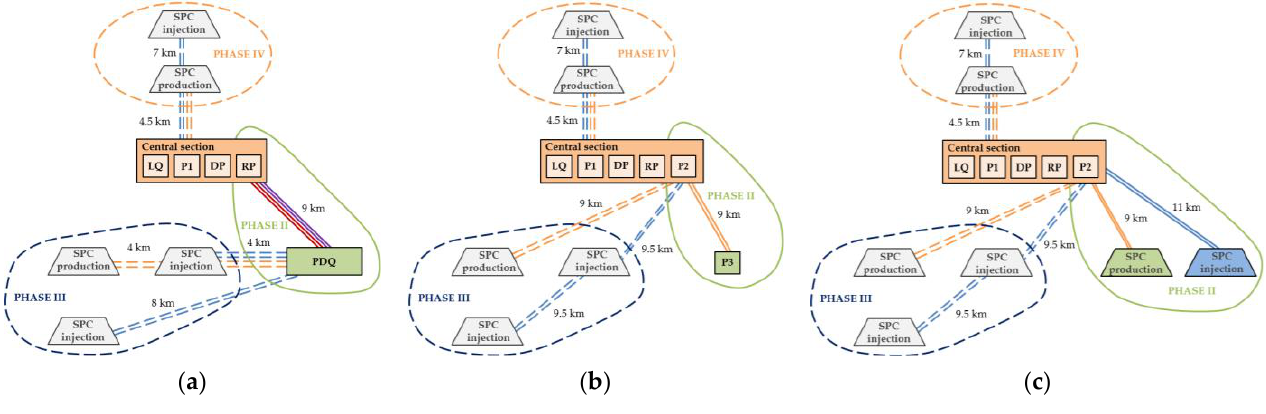
Figure 5. The arrangement scheme of the Avaldsnes section according to: ( a ) Scenario 1; ( b ) Scenario 2; ( c ) Scenario 3.